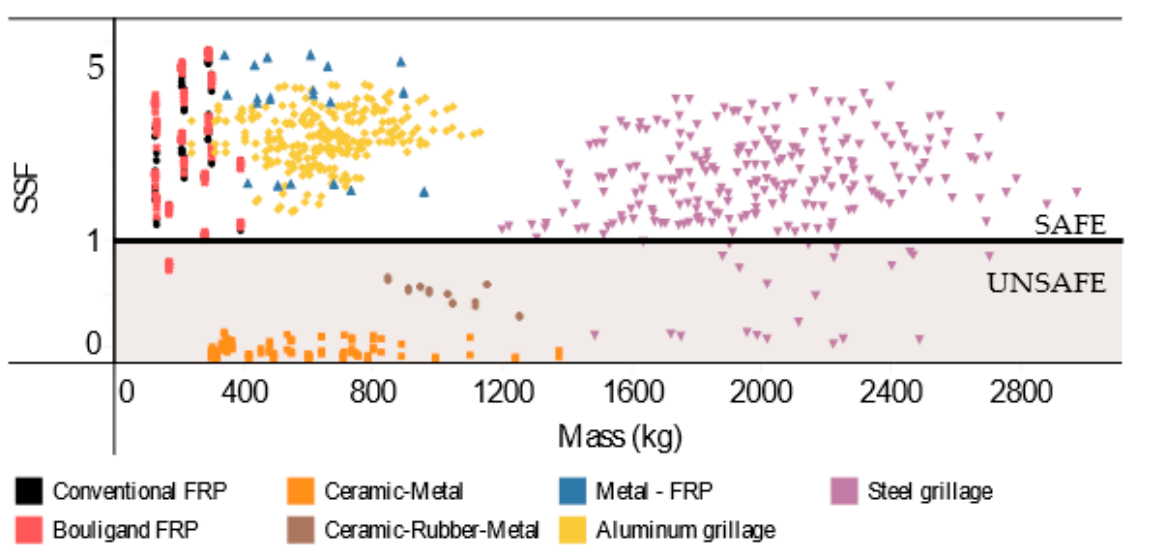
Figure 7. Comparison of stress safety factor of structural concepts with mass ( Y axis is in log scale).